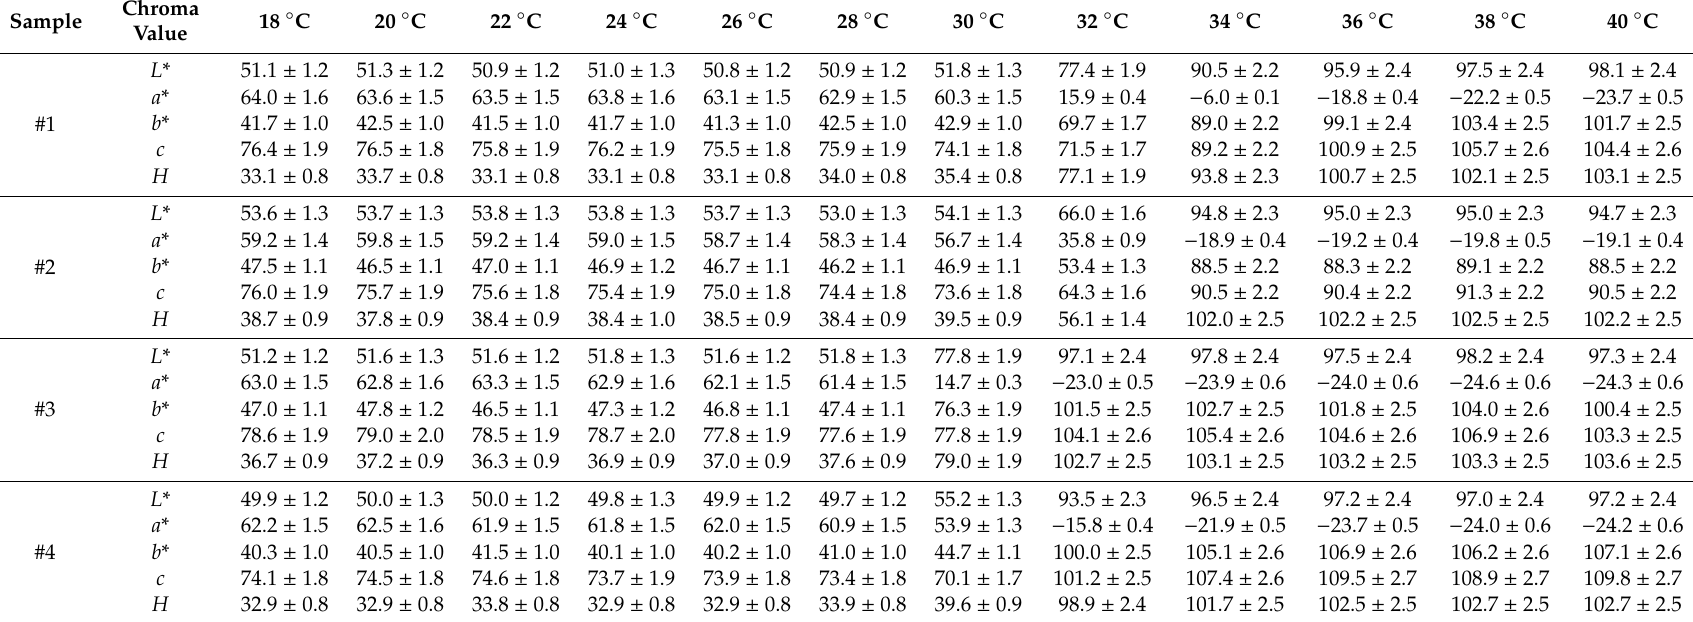
Table 3. E ff ect of the coating process on the chroma value of the waterborne coating with color-changing powder on Chinese fir from 18 to 40 ◦